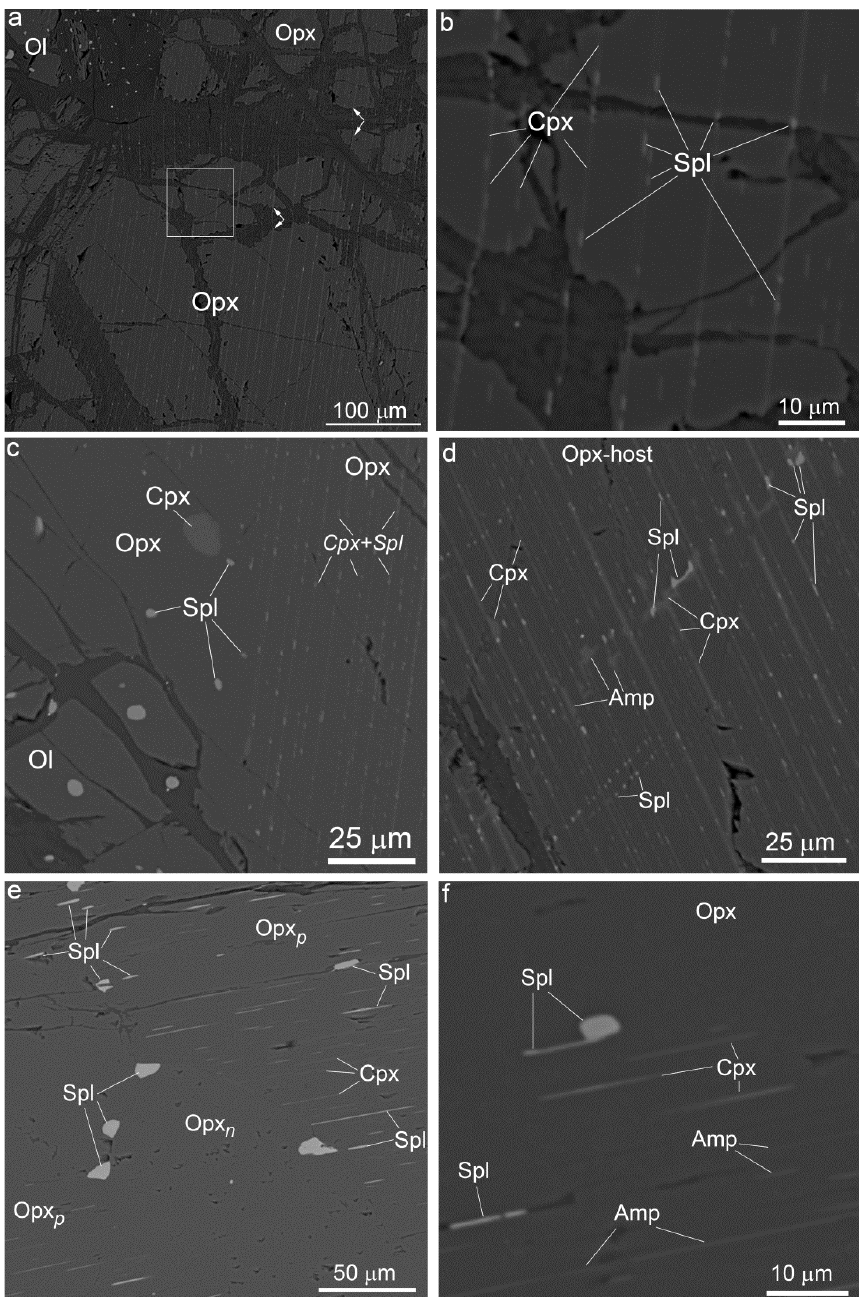
Figure 10. Formation and coalescence of precipitates in deformed orthopyroxene grain: ( a )—General view of orthopyroxene porphyroclast with parallel zones containing by tiny crystals of diopside, spinel and pargasite (arrows noted bends induced by plastic deformation); ( b )—Detail of the same grain ( a , c )—Boundary in Opx grain: on the right, grain have fibrous structure caused by numerous sub-micrometer precipitates of spl and cpx; on the left, grain contains rare isometric inclusions of cpx and spl, similar spinel inclusions are observed in adjacent olivine grain; ( d )—Detail of structure of “fibrous” Opx with numerous precipitates of pargasite, diopside and spinel; ( e )—Enstatite neoblast (Opx n ) in deformed porphyroclast of the same mineral (Opx p ): in Opx porphyroclast, we can see abundant spinel and diopside lamellae but Opx neoblast associate with larger isometric grains of the same minerals; ( f ) –Detail of internal building of Opx porphyroclast: moment was fixed when spinel lamella are re-organizing into isometric grain. Images ( a – d )—sample 809/347, ( e – f )—sample 820/300.